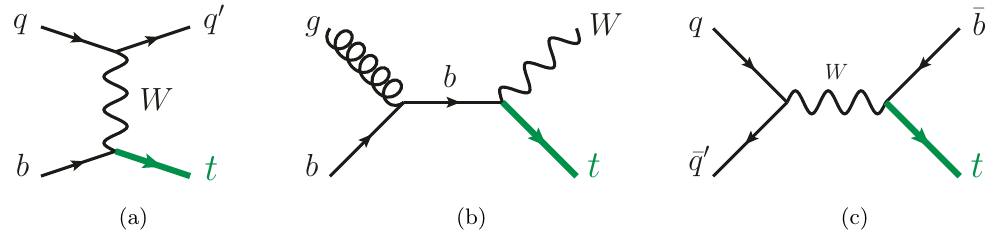
Figure 1 . Representative Feynman diagrams at LO in QCD and in the (cid:12)ve-(cid:13)avour-number scheme for single-top-quark production in (a) the t -channel, (b) tW production, and (c) the s -channel. producing a t -quark and a W boson. The measurement of this process su(cid:11)ers from a large background from top-quark pair ( t (cid:22) t ) production [34, 35]. The s -channel cross-section